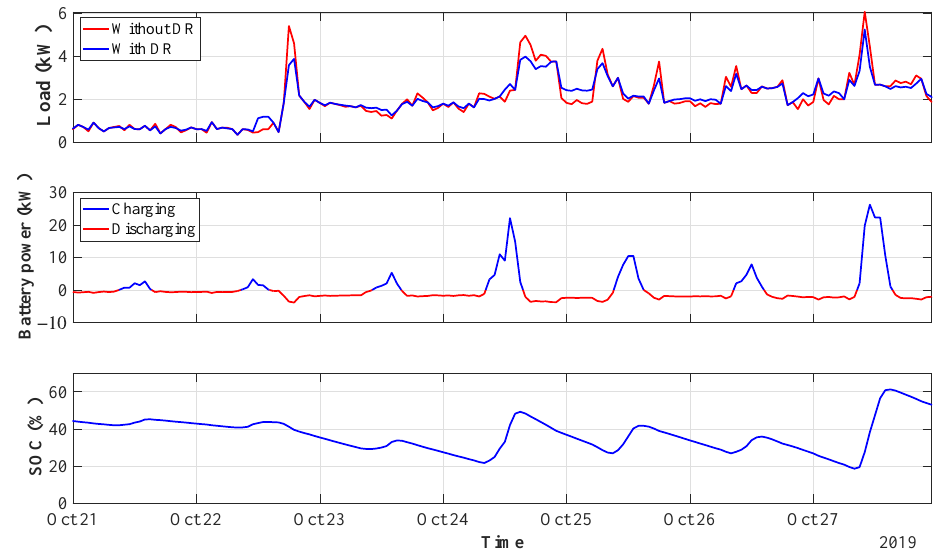
Figure 15. DR and BESS in late autumn.